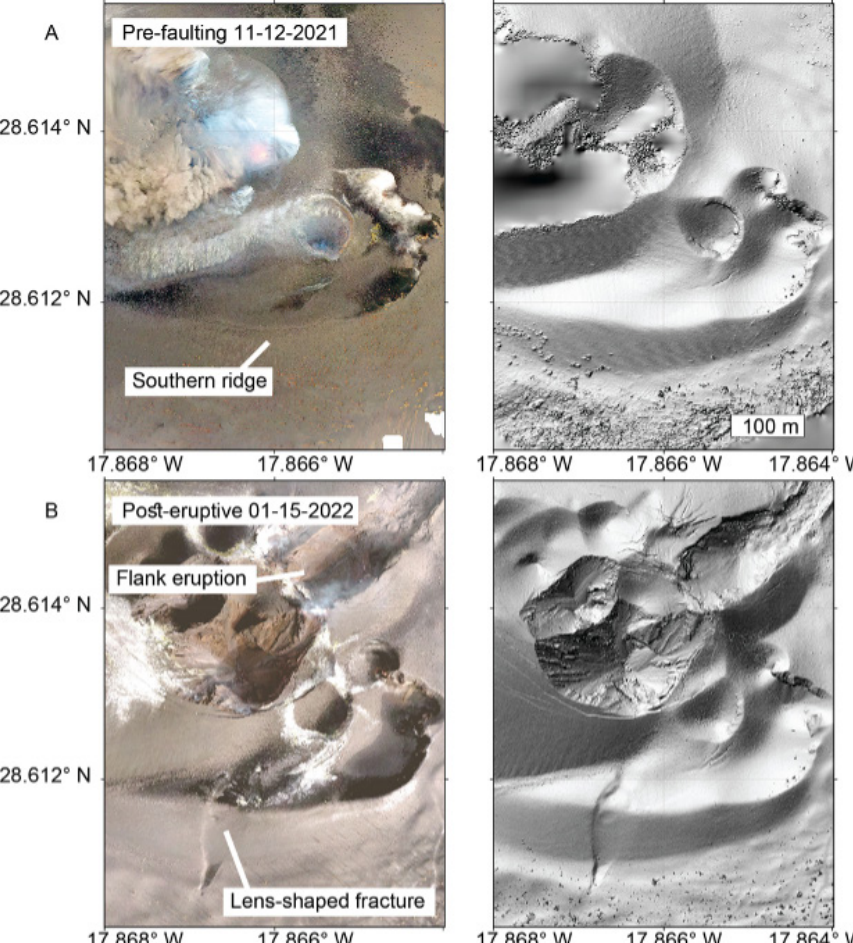
Figure 5: Drone-based orthomosaic (left) and shaded relief map (right). [A] Data acquired before the fracture event reveals the crater row and presence of the southern ridge that is a pre-eruption morphology. [B] Data acquired after the eruption shows the lens-shaped fracture set on the south side, and the flank eruption site to the north, located eccentric to the crater